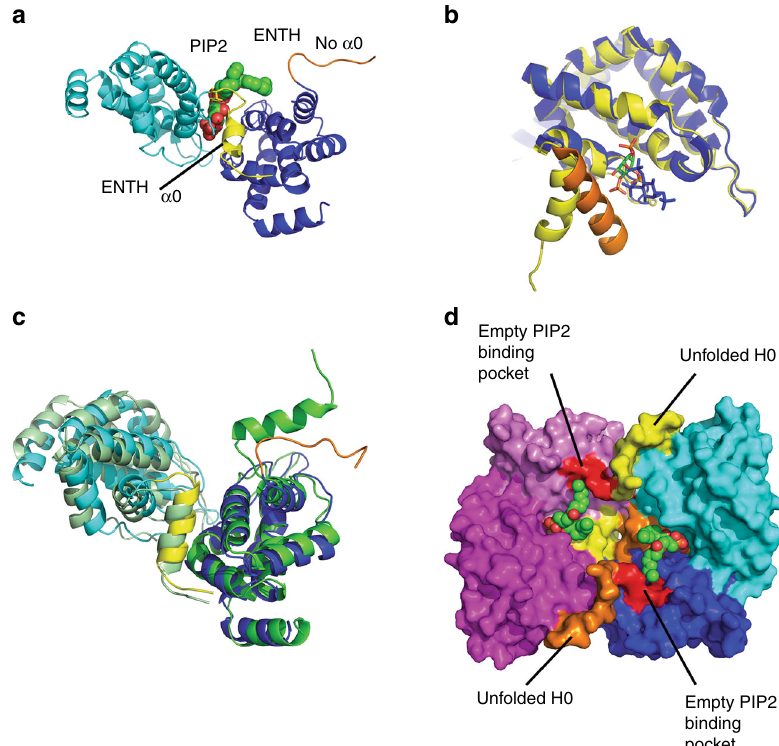
Fig. 2 Crystal structure of the ENTH2/PIP2 complex reveals an allosteric-binding mechanism. a Ribbon diagram of the ENTH2 α 0 (cyan) and ENTH2 No α 0 dimer (blue) building block. N-terminal regions are colored (ENTH2 α 0 , yellow; ENTH2 No α 0 , orange). PIP2 sitting in the interface between ENTH2 molecules is shown as spheres. b Superposition of the ENTH/IP3 epsin-1 complex (dark blue) and the ENTH2/PIP2 complex (yellow). The N-terminal α 0 is colored (ENTH2/PIP2, yellow; ENTH/IP3, orange), the inositol head groups are shown as sticks. c Superimposition of the ENTH2/PIP2 dimer (blue/cyan) and the ENTH1 dimer (green/palegreen) shown as a ribbon diagram. The α 0 helix of ENTH1 is oriented similarly to α 0 of ENTH2 α 0 . d Surface presentation of the ENTH2/PIP2 complex showing that unfolded N-termini of ENTH2 are in plane with the lipid tail of the PIP2 molecules (two ENTH2 α 0 /ENTH2 No α 0 building blocks, cyan/blue and magenta/violet; PIP2, spheres; N-termini for empty ENTH2, yellow and orange; Tyr 16, Arg 24, Arg 62 and His 72 of ENTH2 No α 0 with empty PIP2-binding pocket,